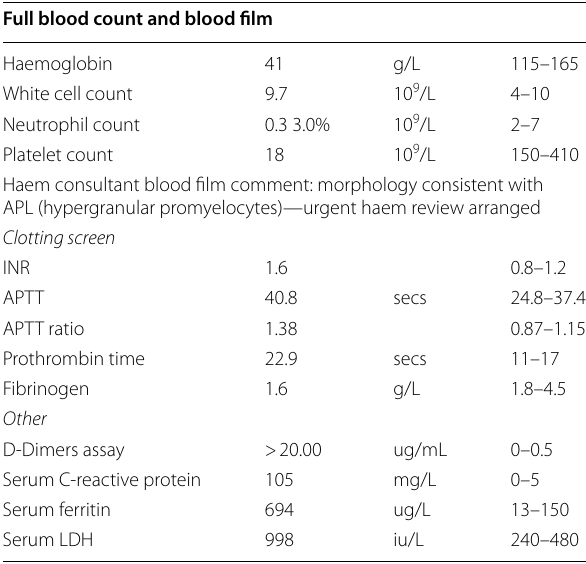
Table 1 FBC, Blood Film, Coag, Fib, D-dimer, CRP, Ferritin, LDH Full blood count and blood